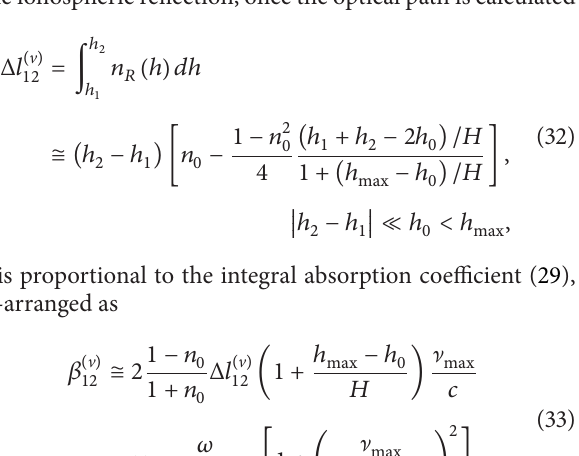
Figure 2: Comparison between two profiles of electron density modelling the ionospheric D-layer between the heights ℎ 1 and ℎ 2 > ℎ 1 .